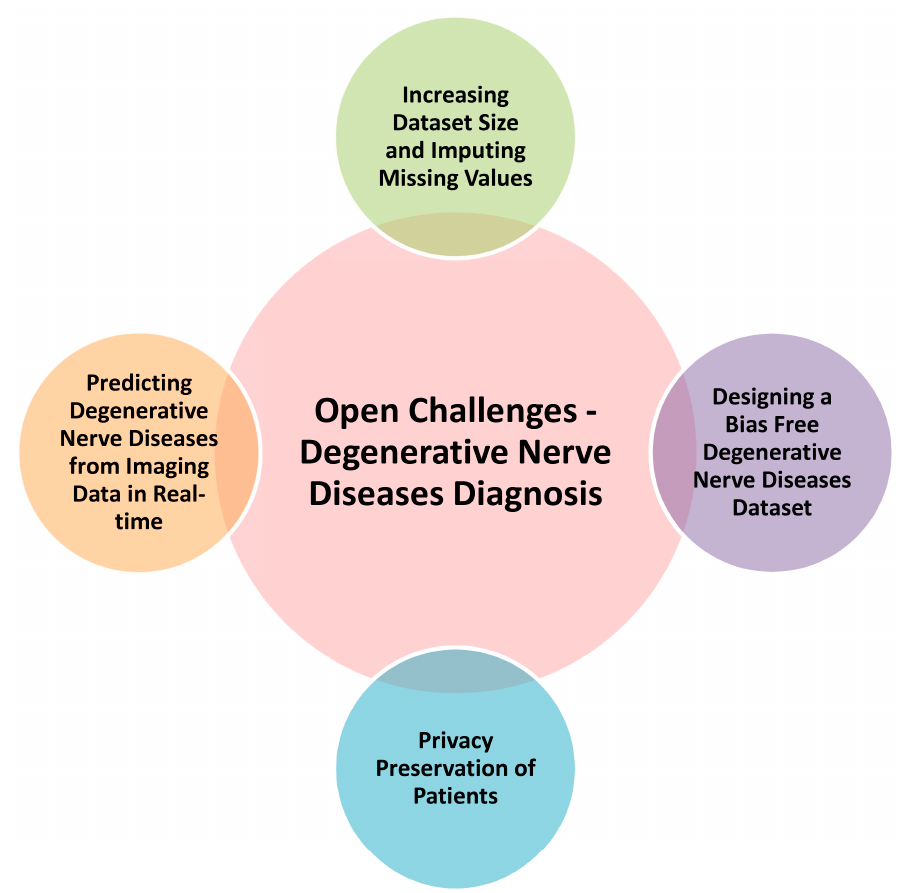
Figure 6. Open challenges in degenerative nerve disease diagnosis.